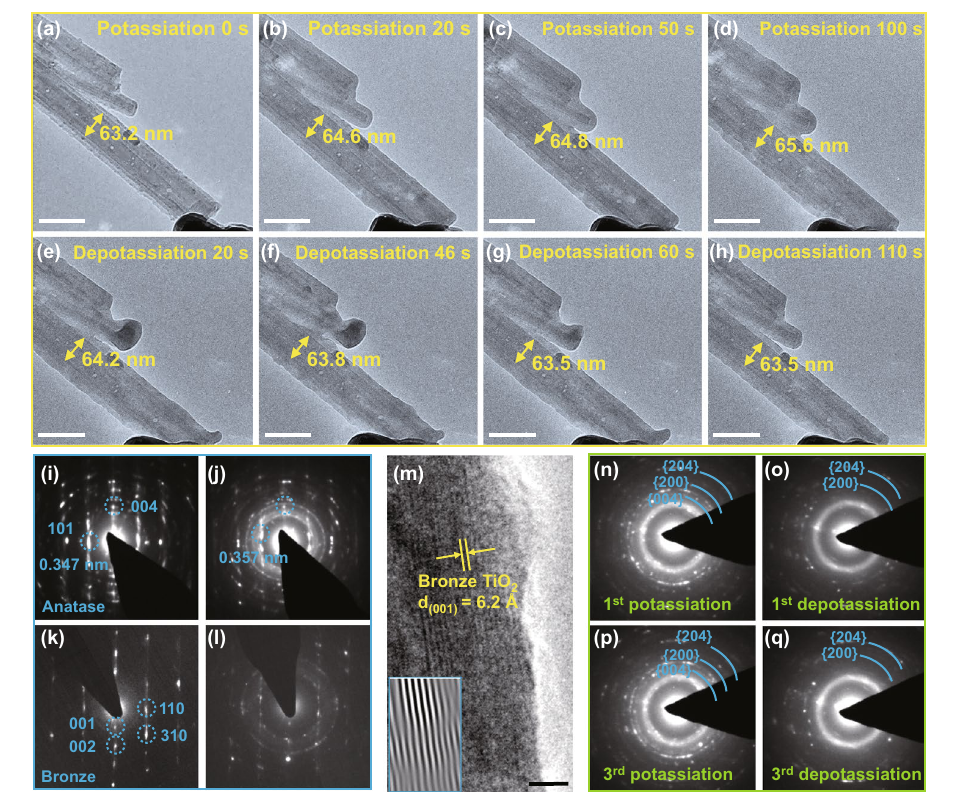
Fig. 3 In situ TEM study of G‑TiO 2 NTs upon potassiation/depotassiation. a – d Time‑resolved TEM images showing first electrochemical potas‑ siation process of G‑TiO 2 NTs: a A pristine G‑TiO 2 NT. The potassiation was initiated by applying a potential of − 2.0 V to the NTs. b , c Small expansions in G‑TiO 2 NTs induced by K‑ion insertion. d Fully potassiated G‑TiO 2 NTs. e – h The first depotassiation process of G‑TiO 2 NTs, with a potential of +2.0 V applied to extract K ions. i Pristine ED pattern of anatase phase. j Full potassiation ED pattern of anatase phase. k Pristine ED pattern of bronze phase. l Full potassiation ED pattern of bronze phase. m HRTEM image of potassiated G‑TiO 2 NTs. Inset shows that lat‑ tice fringes of (001) plane of bronze phase were slightly distorted because of the K‑ion insertion. n – q ED patterns of the first n – o and the third p , q potassiation/depotassiation products to identify the overall reaction mechanism of G‑TiO 2 NTs. Scale bars: a – h 100 nm; m 5